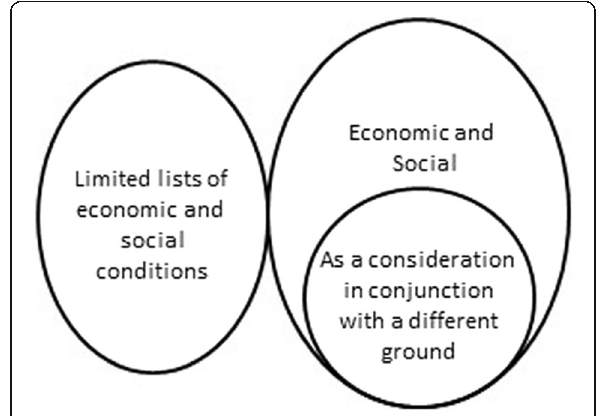
Fig. 4 Relationship between economic or social ground